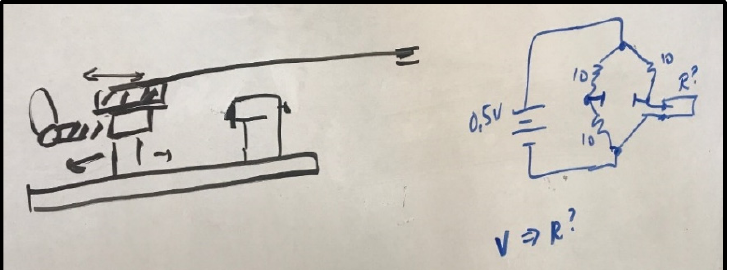
Figure 2. Early concept of SRS linearity testing apparatus.